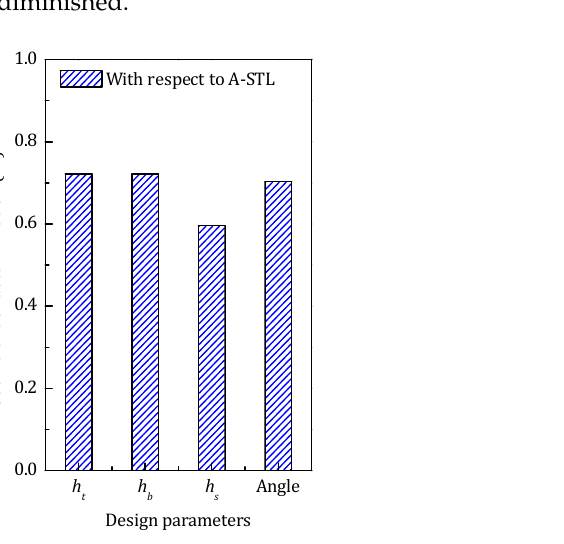
Figure 25. The COD of each design parameter in the middle-frequency range.